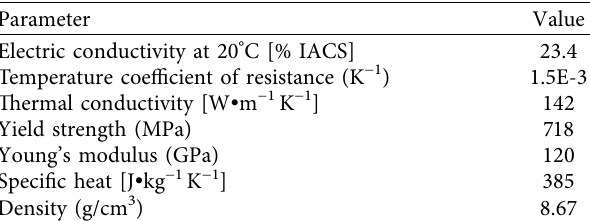
Figure 13: The relationship between ln σ Table 3: The material parameters of CZNS [26, 40].